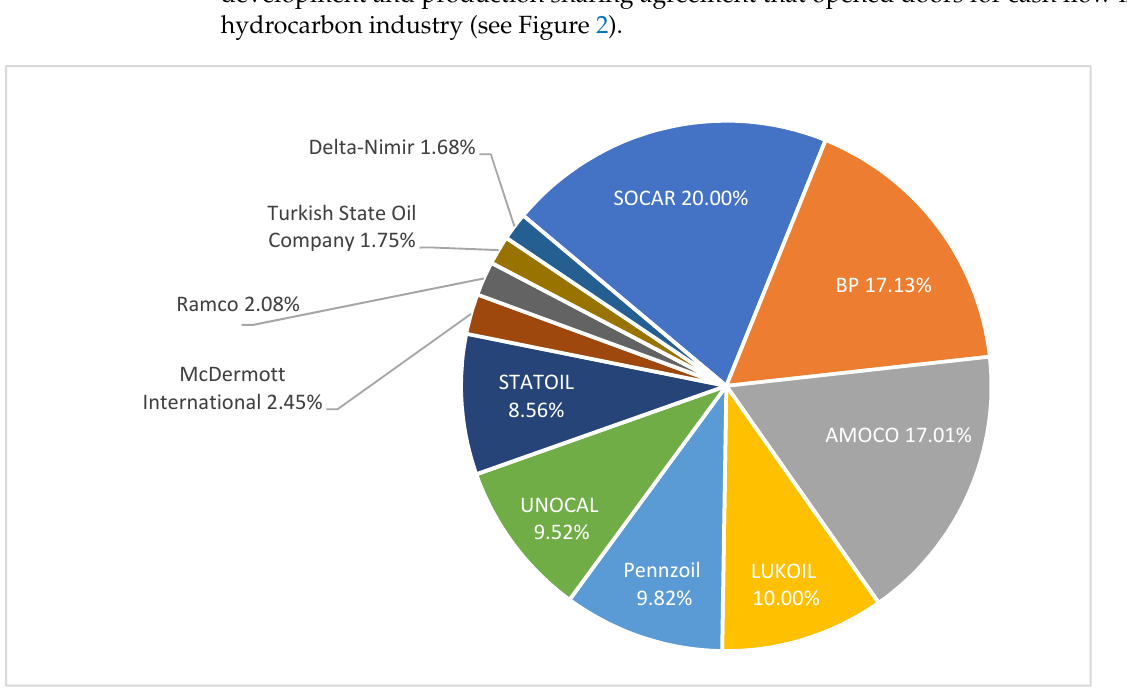
Figure 1. Power generation and types of resources used in Azerbaijan (million kWh) [15].